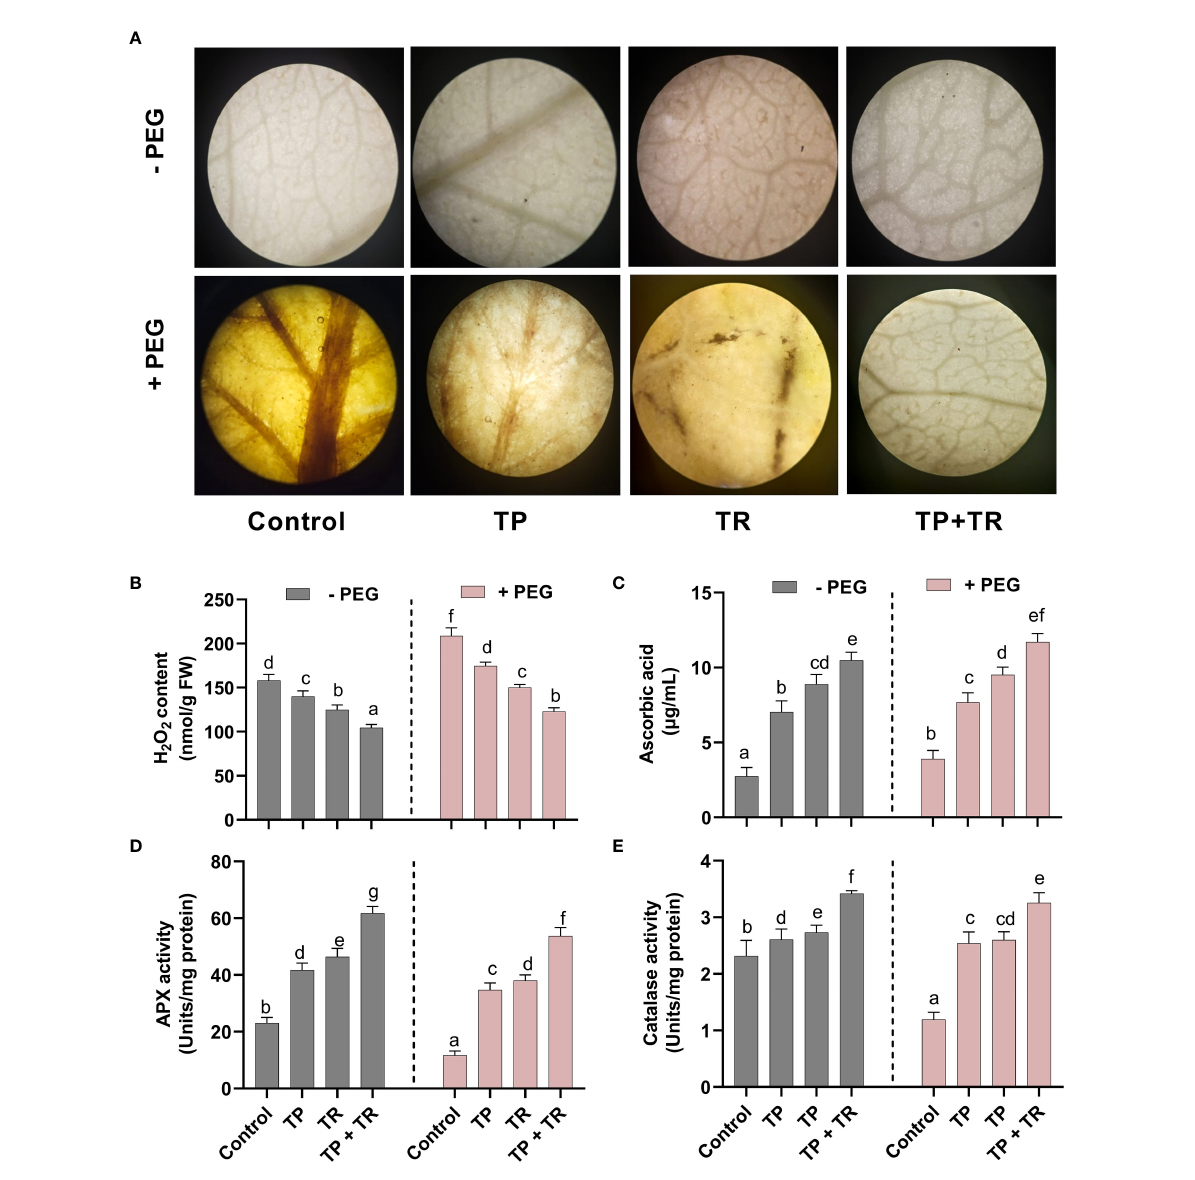
FIGURE 8 Effect of TP and TR inoculation on M. oleifera ROS production and antioxidant potential. (A) DAB staining using leaf segment from 35-d-old plants, (B) H 2 O 2 , (C) AsA, (D) Peroxidase activity and (E) Catalase activity. Quantitative data is representing the means ± SE values of at least three independent biological replications. Various letters have been presented to show the statistical differences at signi fi cance level of p¾ 0.05 using Duncan ’ s Multiple Range Test